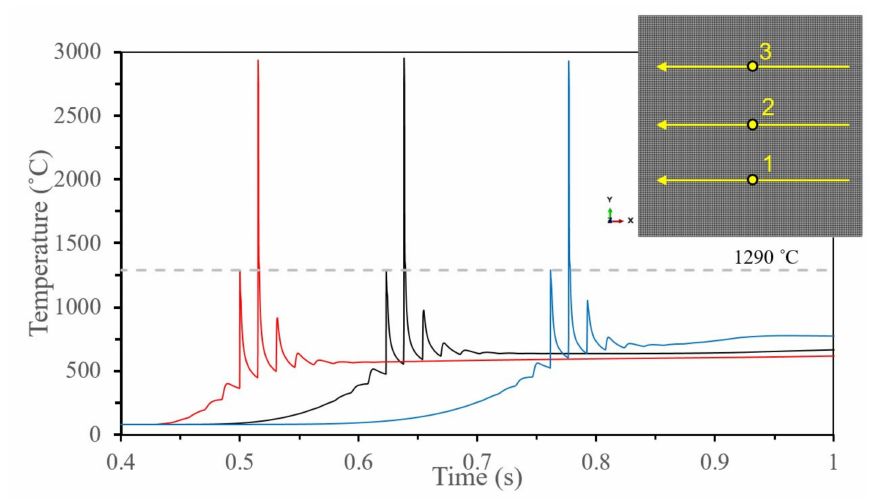
Figure 15. Temperature history at 220 W, 650 mm/s, and 0.12 mm.